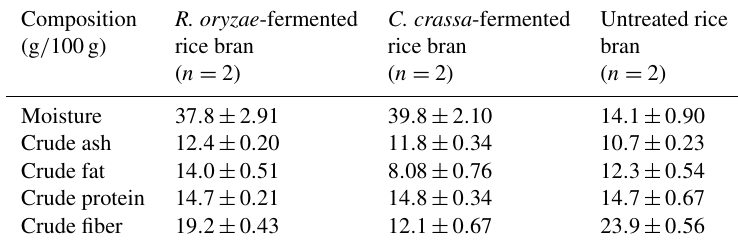
Table 2. Chemical composition of the R. oryzae or C. crassa -fermented rice bran (as dry basis) 1 .